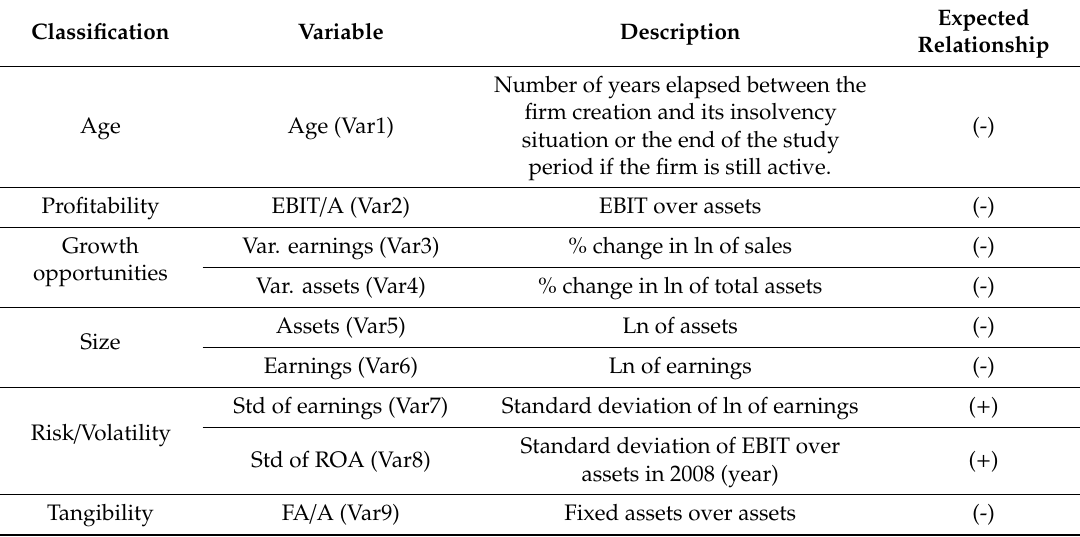
Table 1. Selected variables and the expected impact on default.